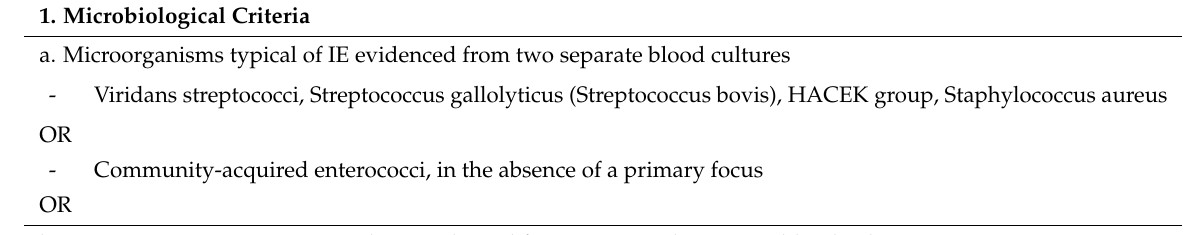
Table 1. Modified Duke-Li criteria for the diagnosis of valve infective